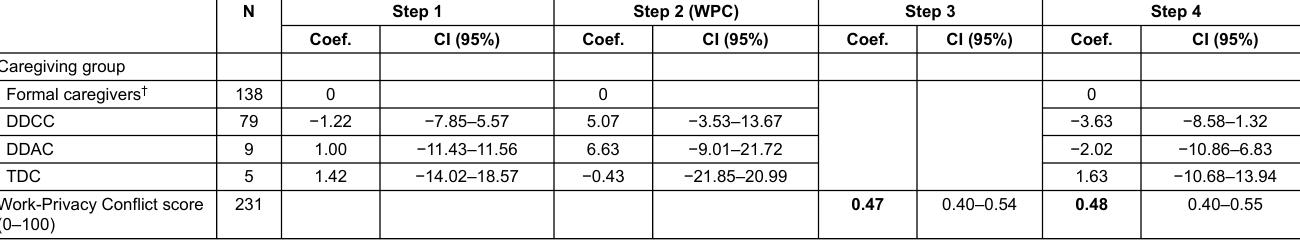
Table 4: Burnout risk for caregiving groups of medical doctors: four-step mediation analyses*. Step 1 Step 2 (WPC) Step 3 Step 4N Coef.